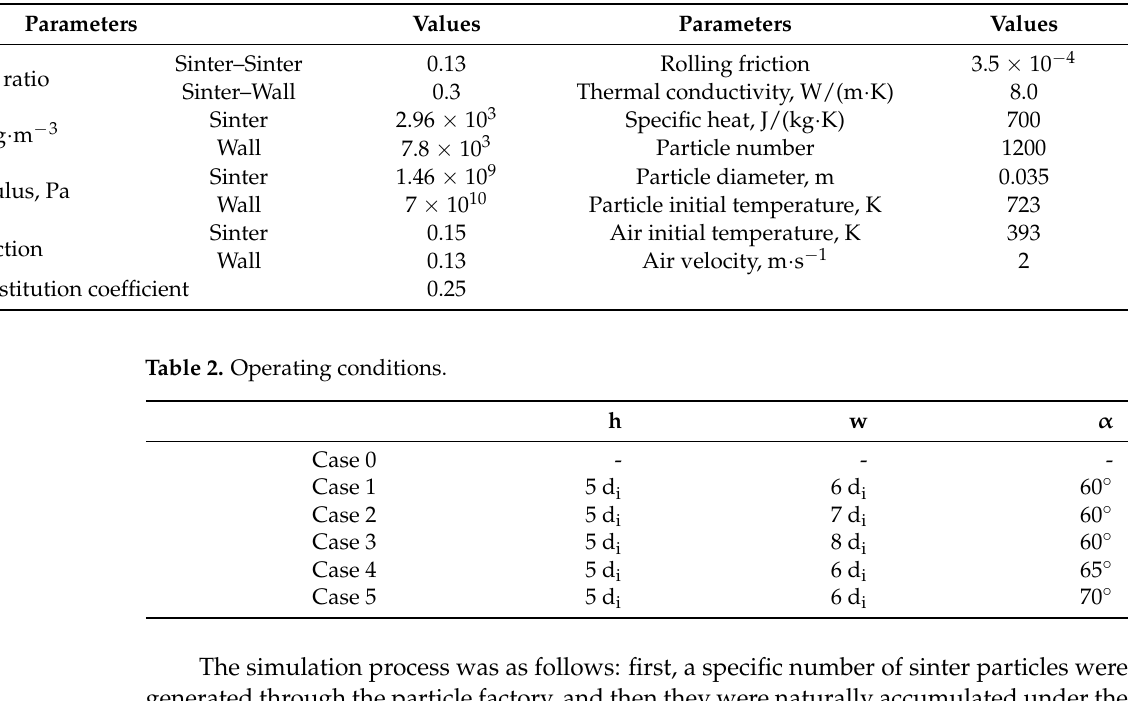
Table 2. Operating conditions.